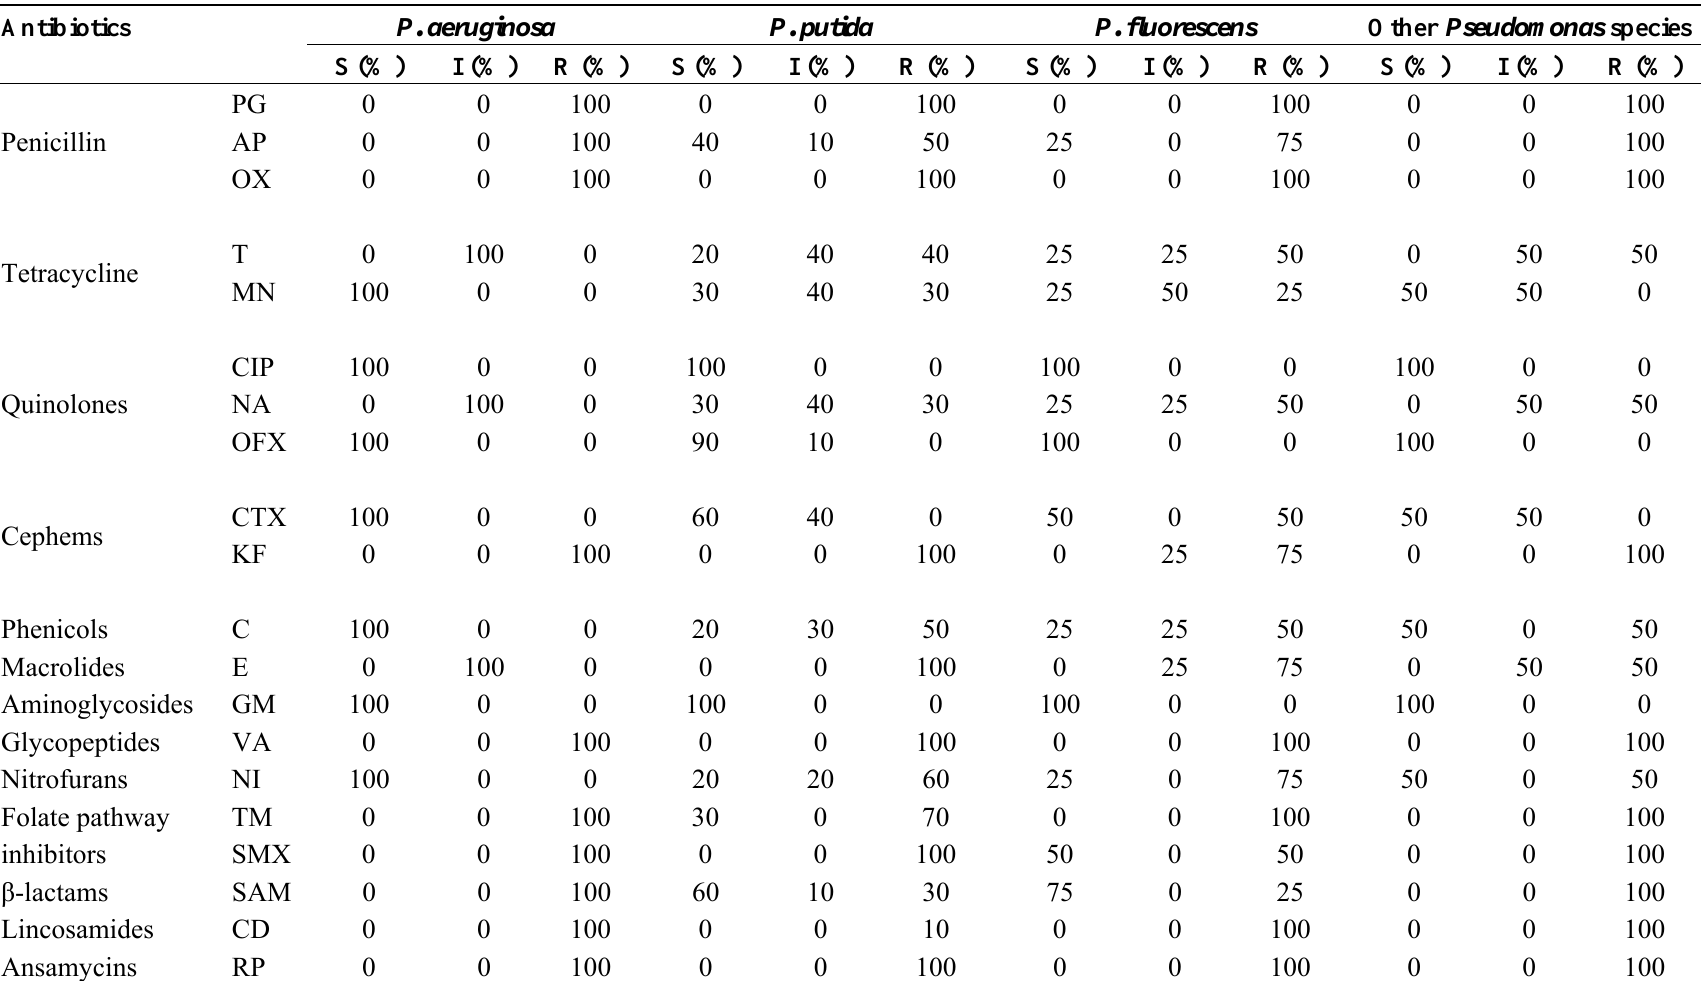
Table 4. Antibiotic susceptibilities of Pseudomonas species isolated from freshwater and mixed liquor samples from Alice. Antibiotics